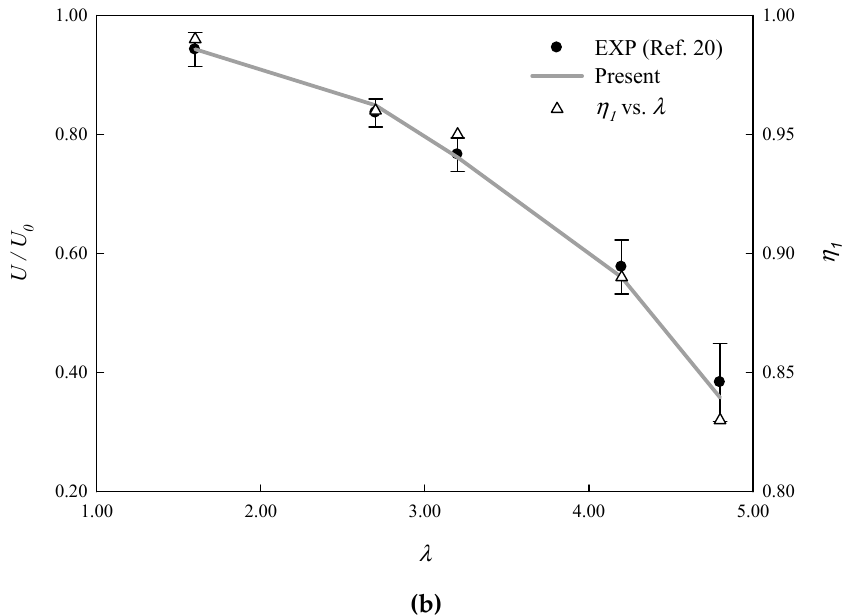
Figure 5. The velocity profile at the wake of model: ( a ) comparison of data [14]; ( b ) comparison of data [20] ( U / U 0 : centerline velocity ratio at x = 1.1 D from the disk).